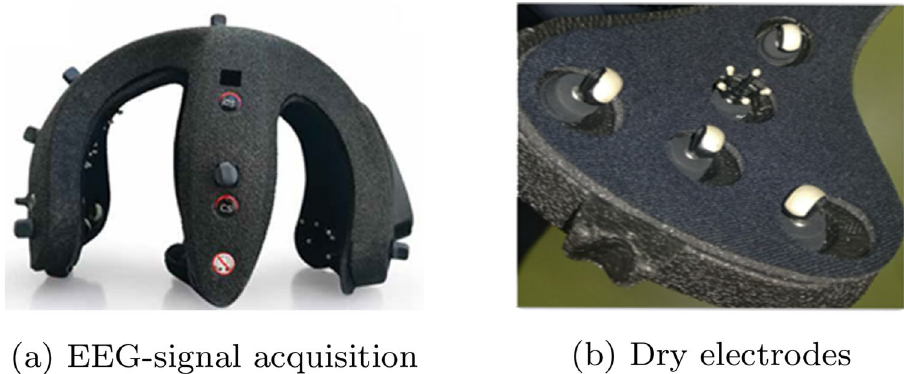
Figure 2. ( a ) EEG-signal acquisition device Helmate8 from abmedica, and ( b ) examples of its dry electrodes 78